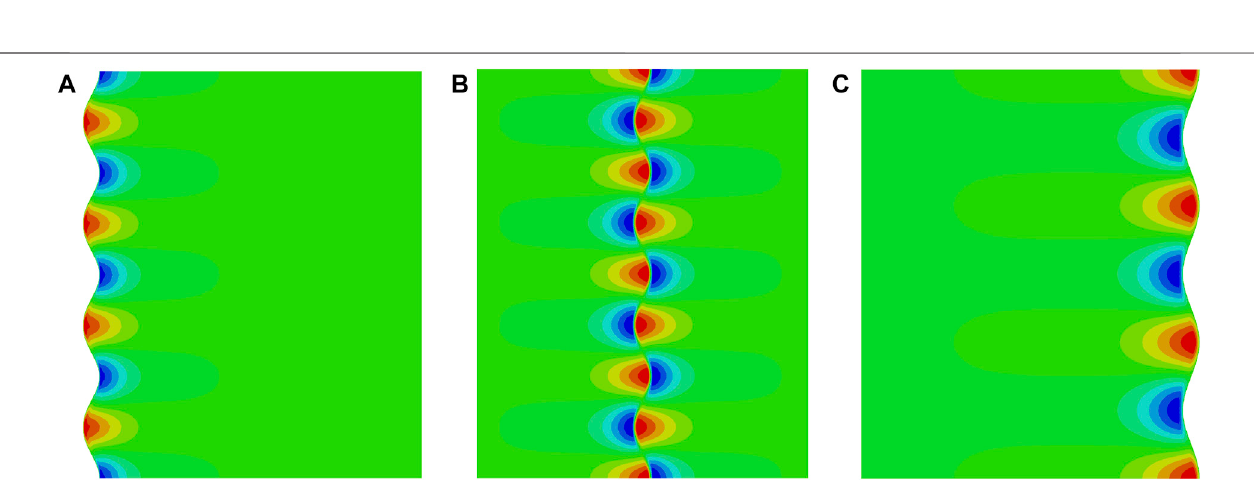
FIGURE 8 | Numerical simulations of instability for a hollow soft cylinder with: (A) an inner stiff layer, (B) a middle stiff layer, and (C) an outer stiff layer. The modulus ratio of the stiff layer E m / E h = 10 3 , and Poisson ’ s ratio ] m = 0.4 and ] h = 0.48.